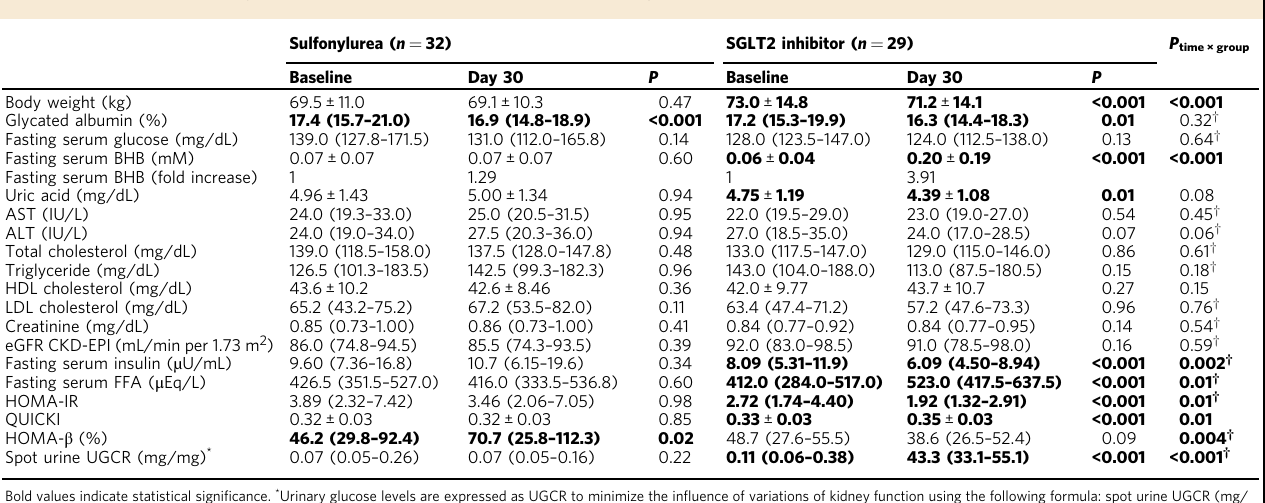
Table 2 Effects of sulfonylurea and SGLT2 inhibitor on metabolic